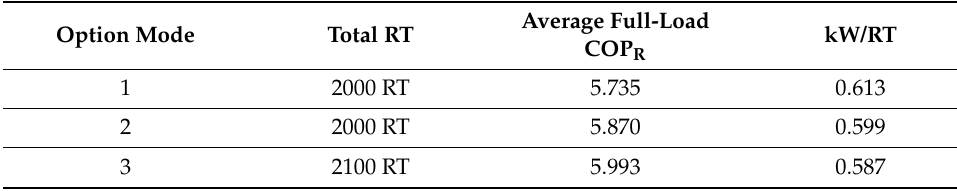
Table 9. Case study analysis 1